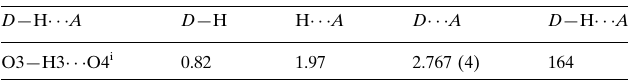
Hydrogen-bond geometry (A˚ , (cid:2)